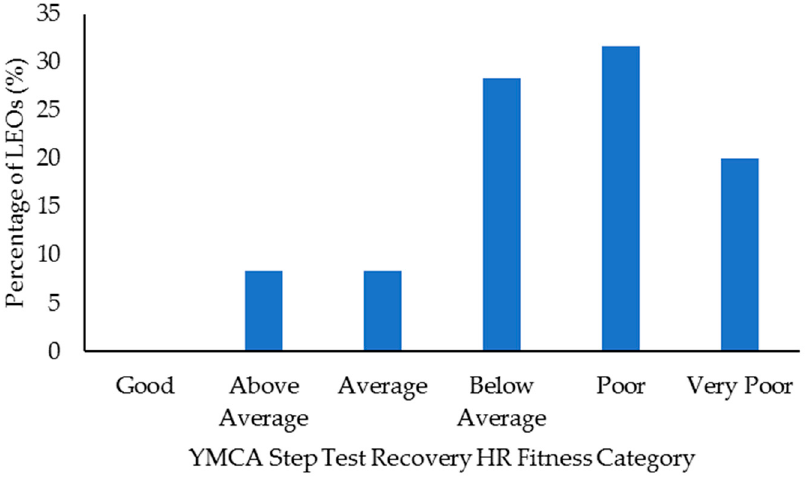
Figure 8. Percentage of law enforcement officers (LEOs) in this sample ( n = 60) classified according to the YMCA step test recovery heart rate (HR) categories.